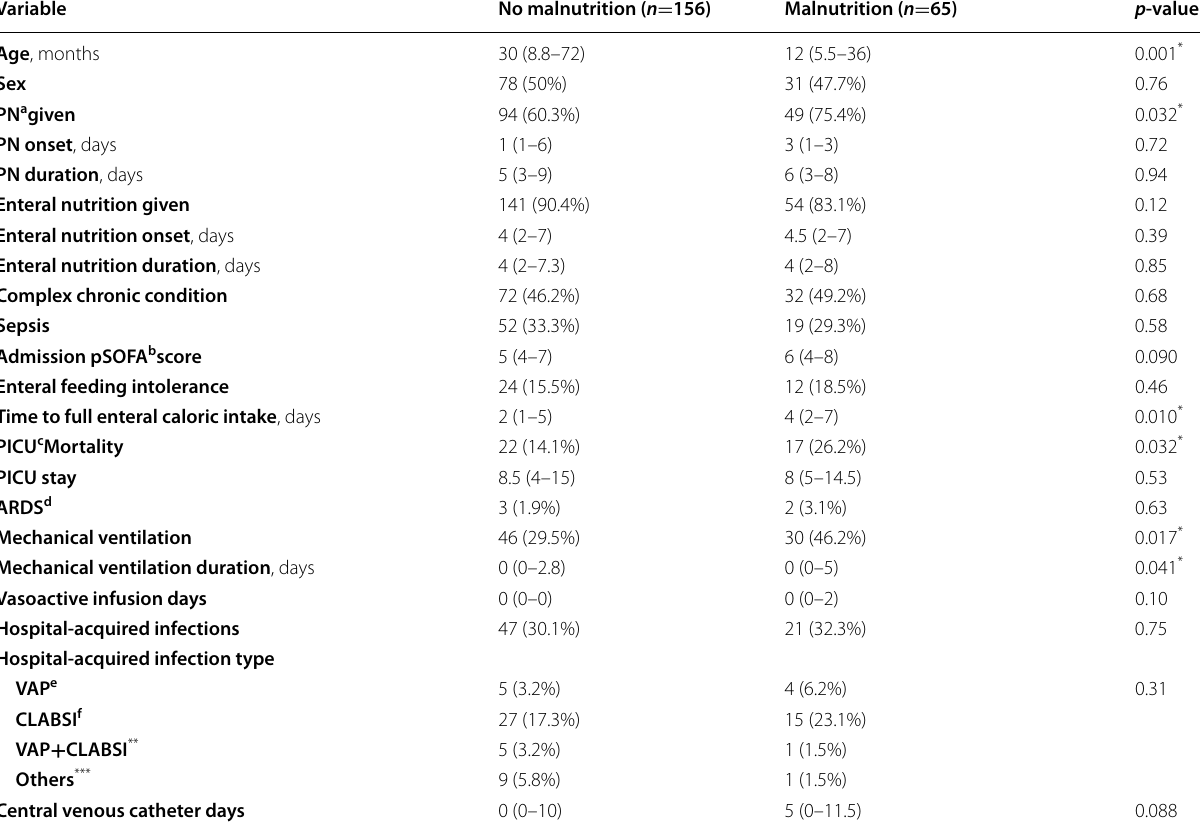
Table 5 Comparison between patients with, and those without,